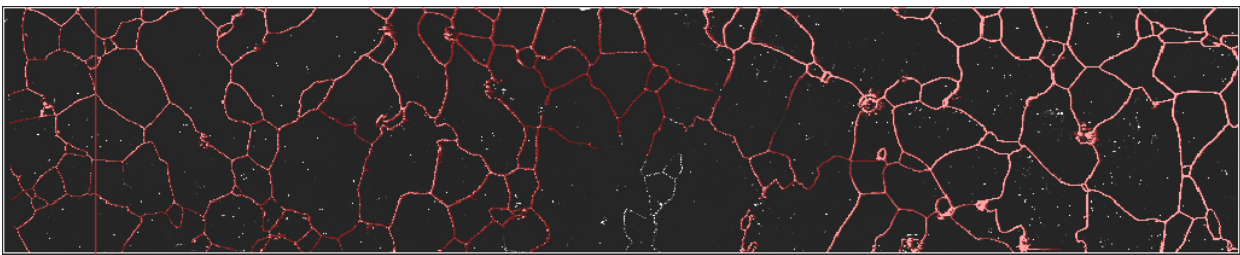
Figure 6. Exemplary results of the watershed algorithm used in HDIP for Na map segmentation of the MIS 2 sample. The red markup is used to classify pixels belonging to grain boundaries. The complement is associated with grain interiors. Note how a small portion in the lower center part was missed by the semi-automated procedure due to a lack of coherency in the Na–grain boundary association. The vertical red stripe on the left image side is an artifact from figure creation.